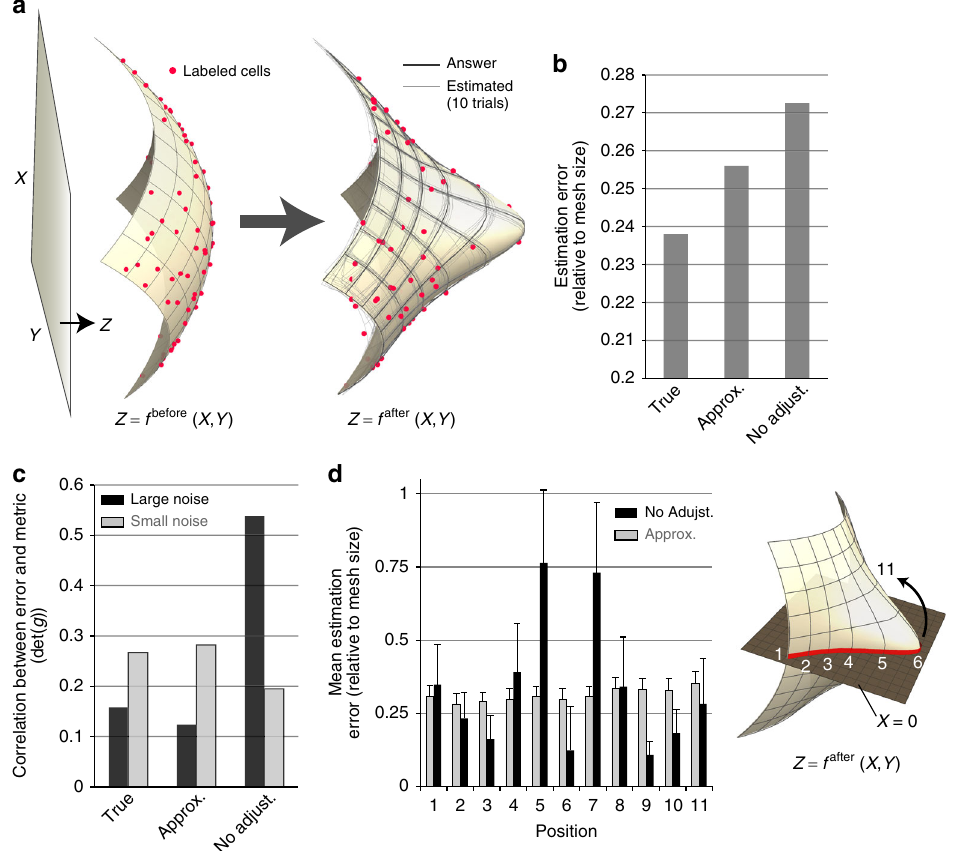
Fig. 4 Validation using arti fi cially generated data I. a A test of how the estimation performance is affected by spatially heterogeneous noise anisotropy resulting from metric anisotropy. We Inferred the deformation map of a surface whose shape before and after deformation can be represented as graphs. b Since the answer of the map was given, the performance of the proposed method was evaluated by its estimation error (see Supplementary Note 4 – 1). The labels, “ True ” , “ Approx. ” , and “ No adjust. ” indicate cases in which the noise anisotropy was calculated using the answer of the map given a priori (Eq. (2)), was approximated using the data point (Eq. (2)), or was not taken into consideration (i.e., 2D isotropic noise was assumed), respectively. Including the noise anisotropy in the likelihood improved the mean estimation error by 5 – 10%, but more importantly, c it prevented spatially biased error; otherwise the error strongly depends on position (more precisely, the error is highly correlated with the size of the induced metric that is measured by det ½ ~ g (cid:5) ), which was clearly observed when the magnitude of noise was not negligible. d Positional dependence of the mean estimation error over 10 estimation trials. The error bar indicates the standard deviation. Incorporating metric-dependent noise anisotropy into the statistical model improves the error bias. In particular, the error in the region with a steep gradient (e.g., at position 5) was clearly